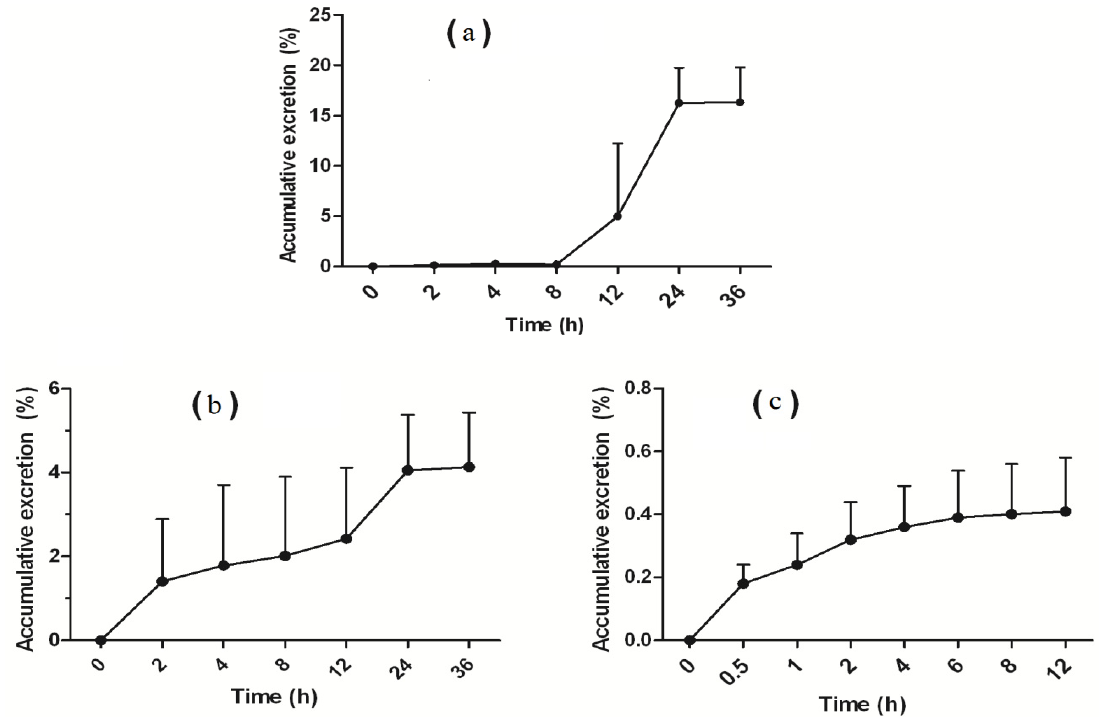
Figure 5. Cumulative percentage of dose excreted in feces ( a ), urine ( b ) and bile ( c ) after intravenous administration of 20 mg/kg wogonin. (mean ± SD, n =